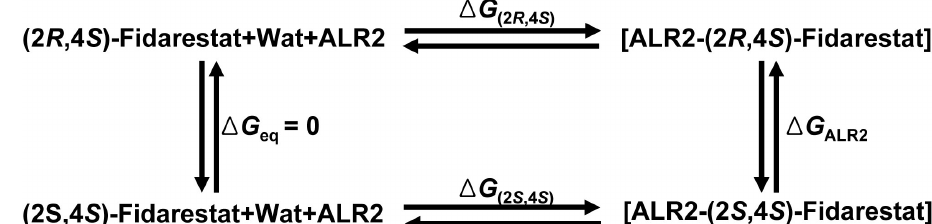
Figure 2. Thermodynamic cycles used for the calculation of relative free energy of binding of (2 R ,4 S )- Fidarestat and (2 S ,4 S )-Fidarestat to the ALR2. ∆ G